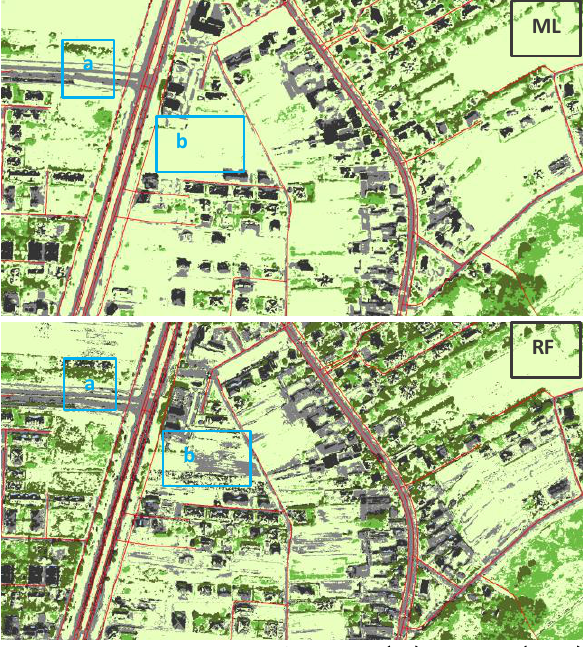
Figure 11. Roads obtained from ML (up) and RF (down)